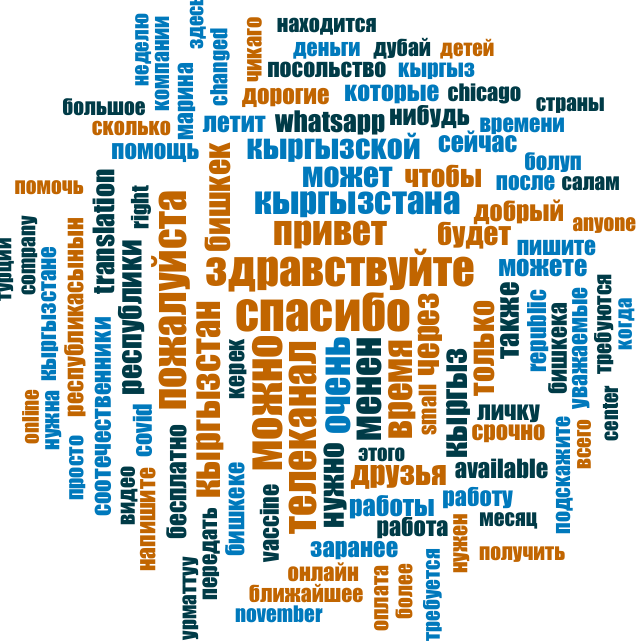
Figure 1. Facebook Groups and Pages: Word Frequency in Posts and Comments.